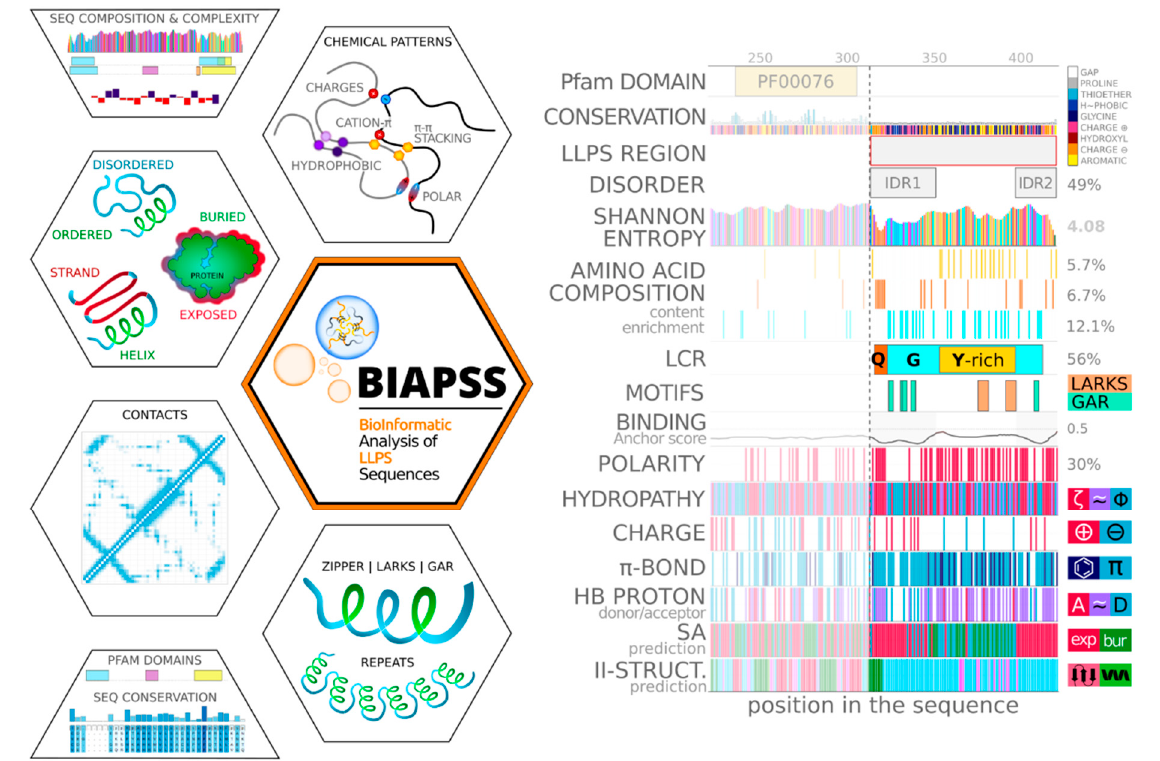
Figure 1. The comprehensive BIAPSS analyzer incorporates the compositional, evolutionary, physicochemical, and structural properties of LLPS proteins. All characteristics can be easily compared and correlated on the horizontally stacked multirow graphs. The interactive exploration helps to filter out sequence signals relevant for phase separation.